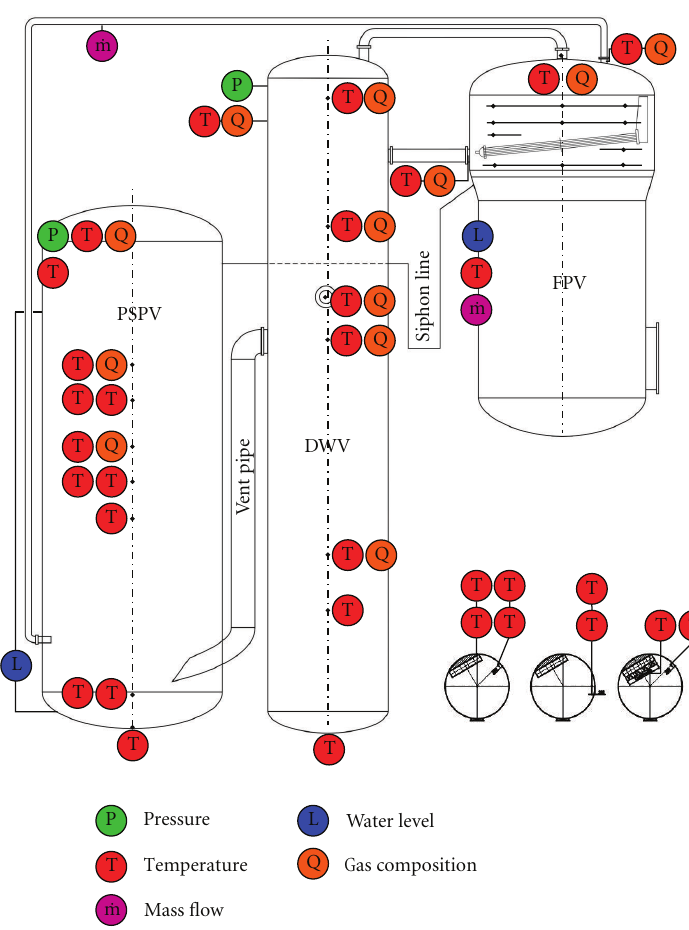
Figure 7: Drawing of the INKA vessel